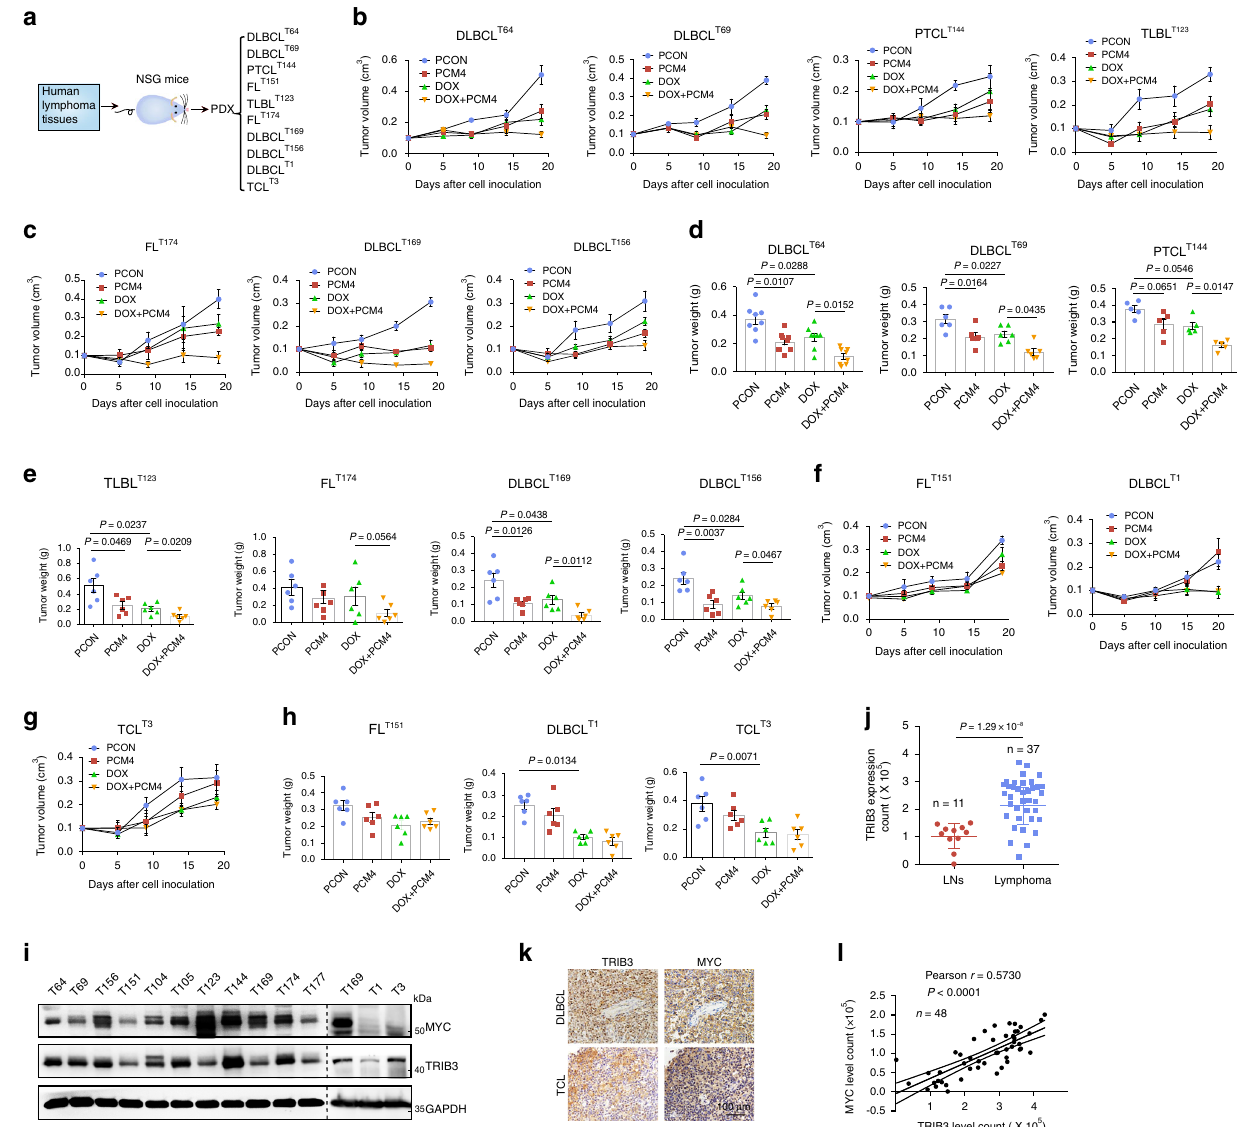
Fig. 8 Combination of PCM4 with doxorubicin inhibits synergistically lymphoma in PDX models. a Strategy for constructing patient-derived tumor xenograft (PDX) models from lymphoma patients. b , c Effects of the indicated treatments on tumor growth in the indicated PDX models. Tumors were subcutaneously engrafted in NSG mice ( n = 8 per group). One day later, the mice were treated with PCM4 (5 mg/kg) or/and DOX (2 mg/kg) for 21 days, and the tumors were measured twice a week. Data are represented as means ± SEM. d , e Effects of the indicated treatments on the tumor weights in the indicated PDX models. (DLBCL T64 n = 8 per group, DLBCL T69 n = 6 per group, PTCL T144 n = 5 per group, TLBL T123 n = 6 per group, FL T174 n = 6 per group, DLBCL T169 n = 6 per group, DLBCL T156 n = 6 per group). Data are represented as means ± SEM. Statistical signi fi cance was determined by two-tailed Student ’ s t test. P values were indicated in the panels d and e . f – h Effects of the indicated treatments on the tumor growth and tumor weights in the indicated PDX models. (FL T151 n = 6 per group, DLBCL T1 n = 6 per group, TCL T3 n = 6 per group). Data are represented as means± SEM. P values were indicated in the panel h . i The expression of MYC and TRIB3 in 13 primary lymphoma cells was detected by western blotting. The dashed line showed the two gels which were probed in parallel. The data are representative of three independent assays. j Statistical analyses of IHC staining of TRIB3 in human lymphoma ( n = 37 samples) and benign lymph node (LN) tissues ( n = 11 samples). TRIB3 expression was assessed as integrated optical density (IOD) scores. The horizontal lines shown in the graphs represent the median of each protein expression level. The data are presented as the means± SEM. Statistical signi fi cance was determined by two-tailed Student ’ s t test. P value: 1.29 × 10 − 8 . k Representative images of IHC staining of TRIB3 and MYC in human lymphoma tissues. The data are representative of three independent assays. Scale bars, 100 μ m. l Correlation between TRIB3 and MYC expression in human LNs and lymphoma specimens ( n = 48). Each data point represents the value from an individual patient. Statistical signi fi cance was measured by Pearson ’ s correlation test. Source data are provided as a Source Data fi